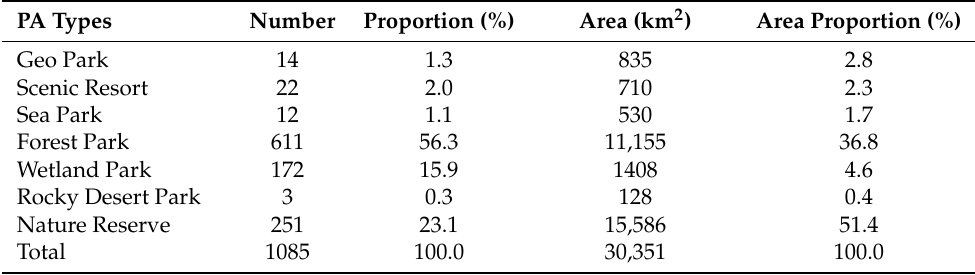
Table 1. Properties of the PAs in